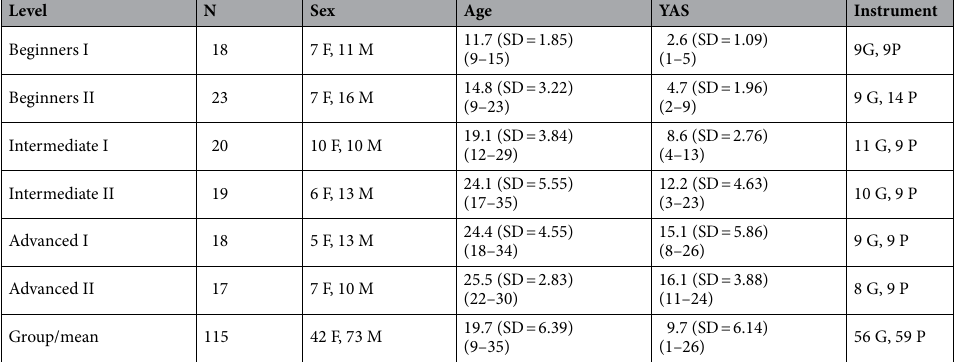
Table 1. Demographic and academic characteristics of participants. F = female, M = male. YAS = years of academic musical studies. G = Guitarists; P = Pianists. The six subgroups were merged into three level categories, Beginners, Intermediate and Advanced, for the purpose of statistical analysis. The mean age and YAS are reported, along with standard deviation values and minimum and maximum